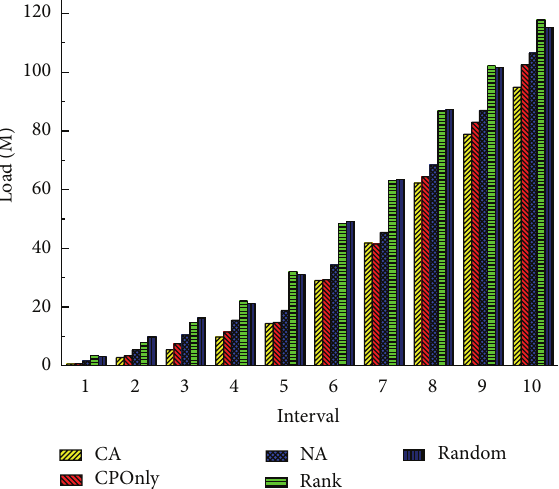
Figure 11: Total load of communication (10